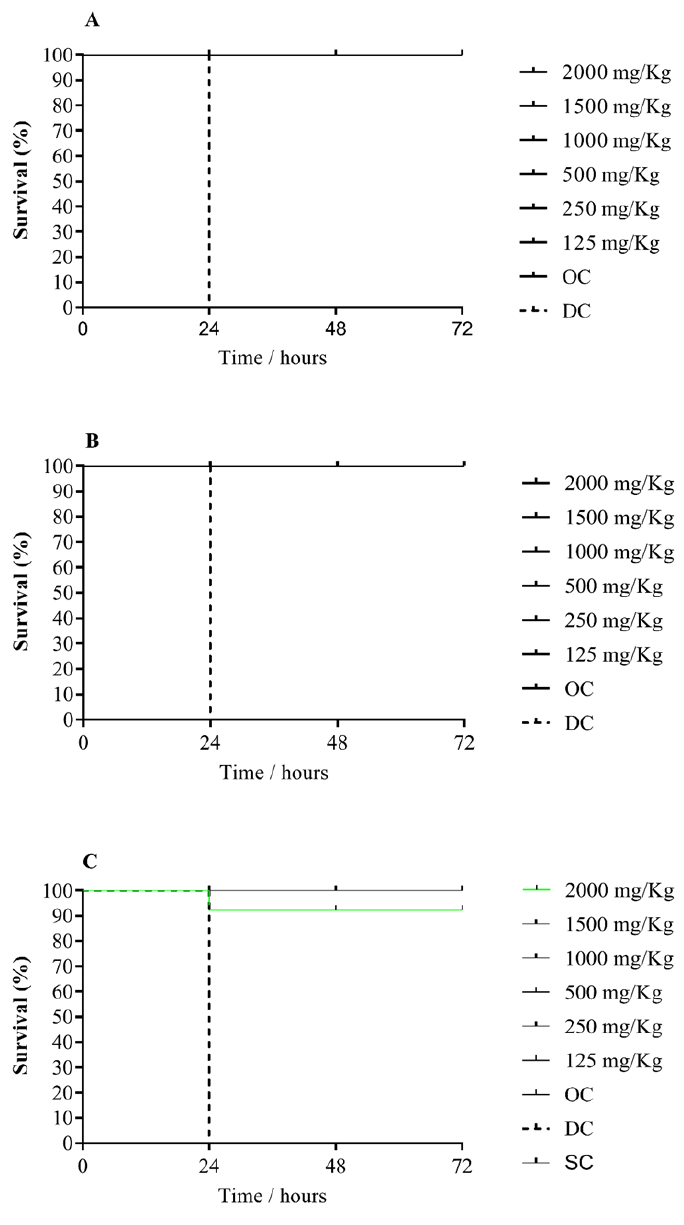
Figure 3. Kaplan-Meier survival curve of G. mellonella larvae for the analyzed groups at six different concentrations. Legend: ( A ): MSN-C. ( B ): MSN-R. ( C ): lycopene.. OC: orifice control group. DC: death control group. SC: solvent control group.